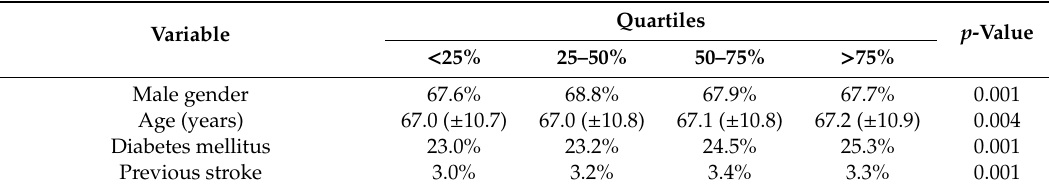
Table 1. Baseline patient characteristics treated by operators divided into quartiles depending on operator’s utilization of radial access